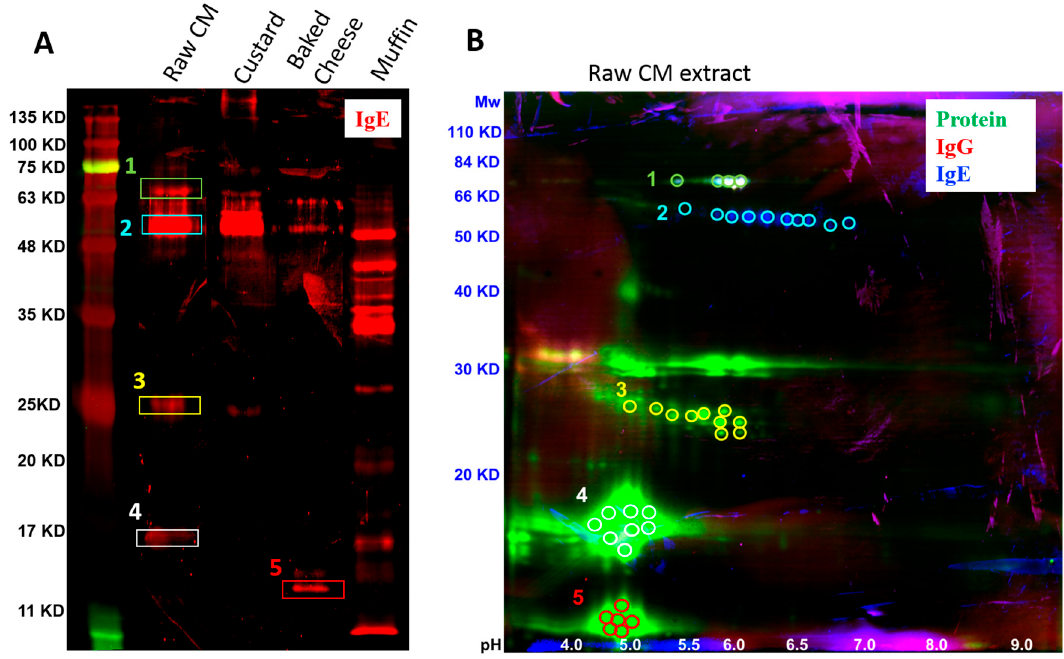
Figure 2. Immunoblot analysis of raw, pasteurized CM and CM-containing food extracts. ( A ) 1-D immunoblot analysis of raw, pasteurized CM, custard, baked cheese and muffin extracts showing IgE-reactive protein bands (red) and ( B ) a 2-D immunoblot analysis of raw, pasteurized CM extract showing protein spots (green) reactive with IgE (blue) and/or IgG (red) from a serum pool from 10 CM-allergic subjects.